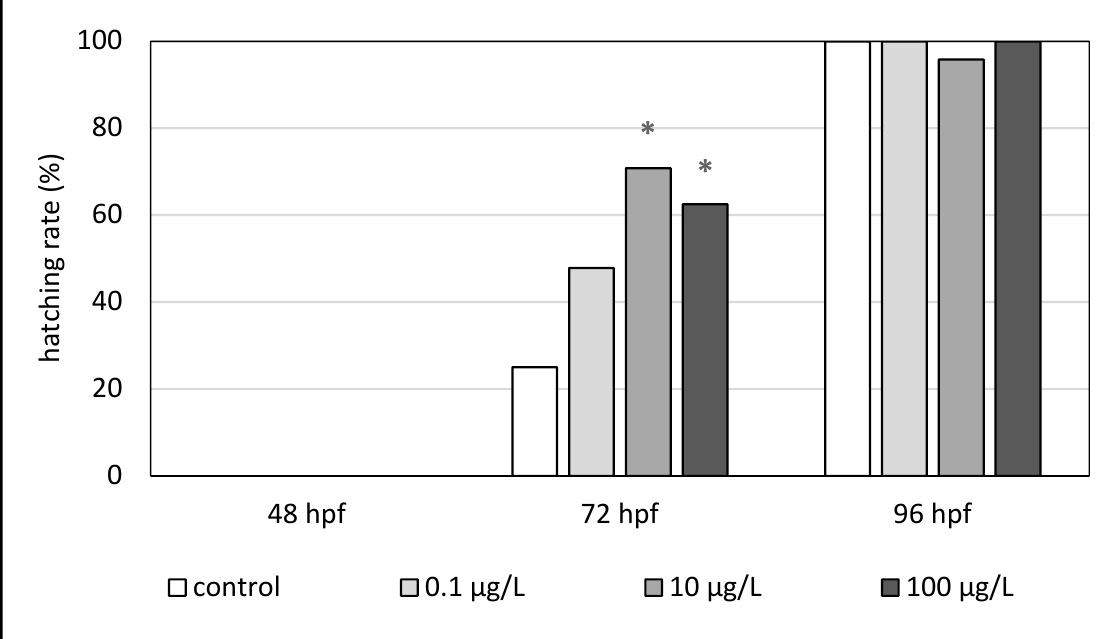
Figure 6. Hatching rate (%) of zebrafish embryos exposed to the combination of 2-phenylbenzimidazole-5-sulfonic acid,